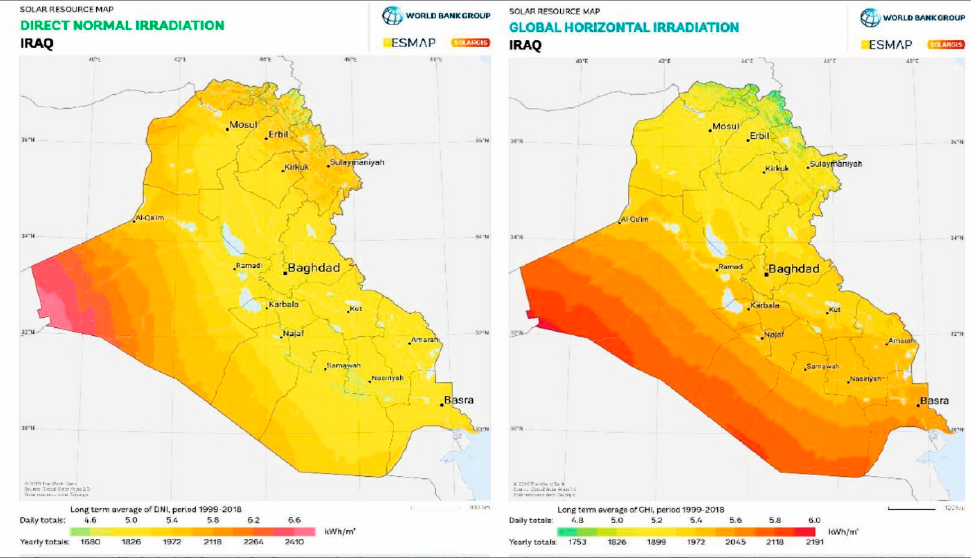
Figure 2. Iraq solar annual direct normal and global horizontal Irradiation map © 2019 The World Bank, Source: Global Solar Atlas 2.0, Solar resource data: Solargis